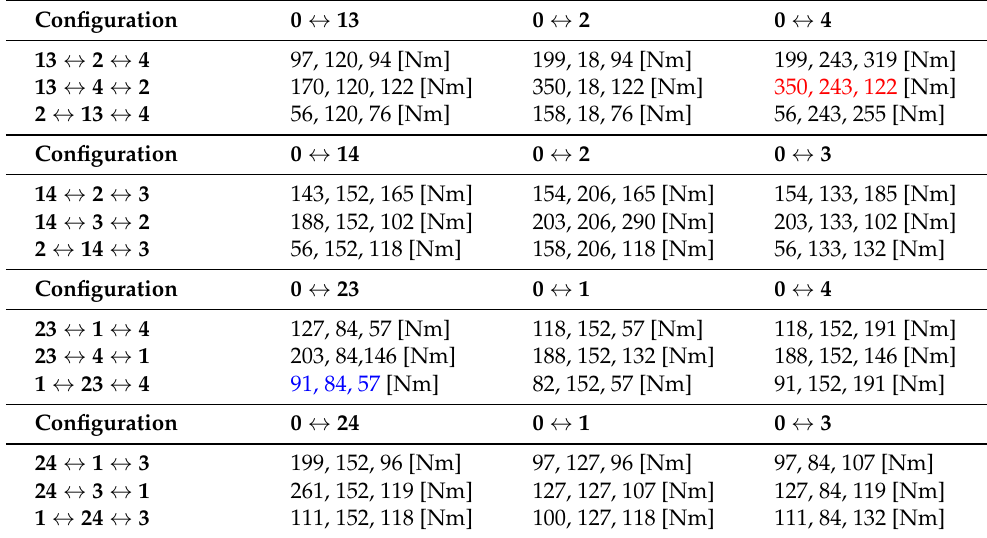
Table 8. Maximum shaft torques for linear VDN topology interconnection schemes with shared chambers in crane application. The Blue colored case marks the scheme with lowest torque sum and the red colored case marks the scheme with the highest torque sum.